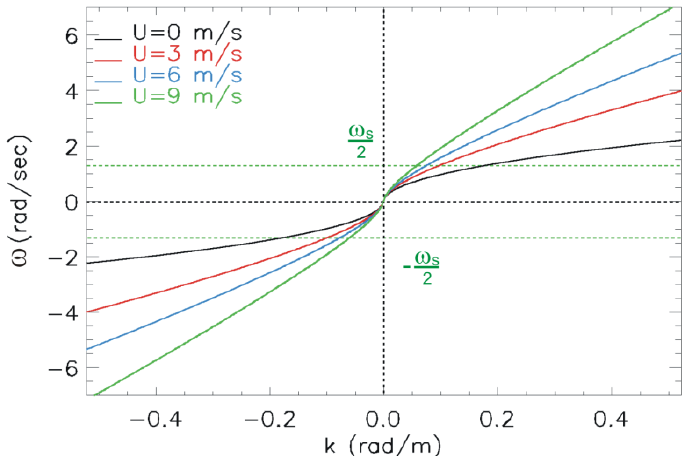
Figure 3. Dispersion relation for the progressive waves when the surface current U